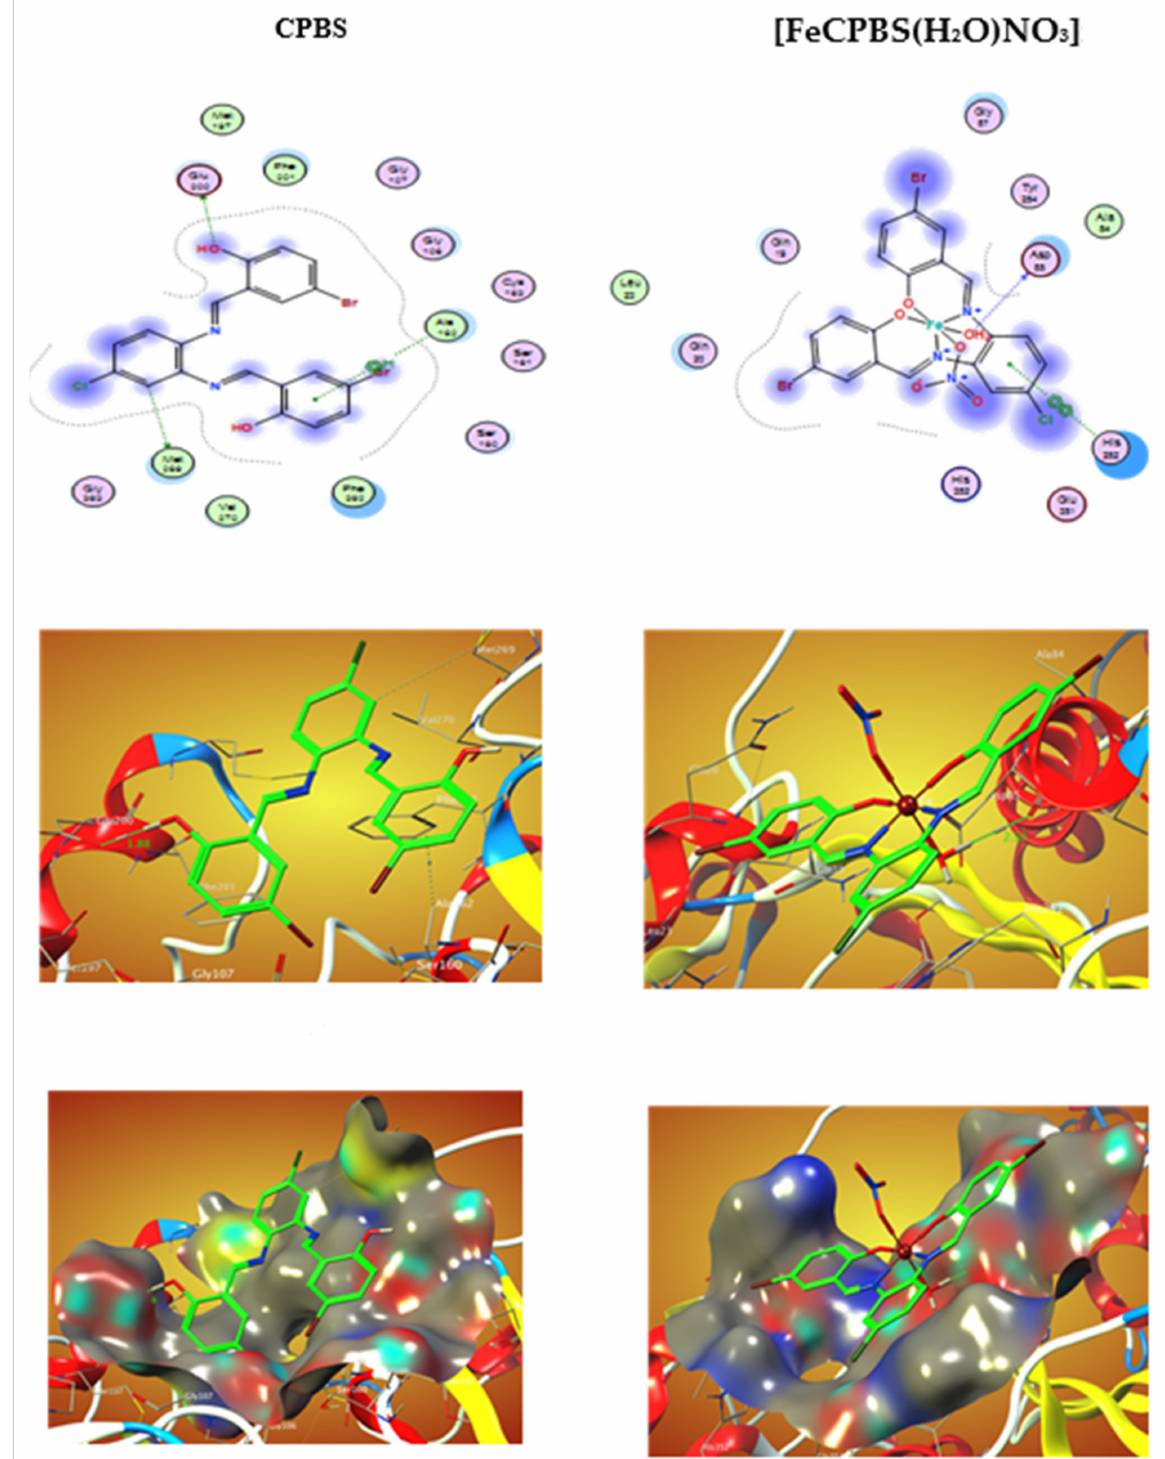
Figure 10. 2D and 3D plots of the interaction between CPBS and [FeCPBS(H 2 O)NO 3 ] with the active site of the Escherichia coli protein receptor (PDB ID: 1fj4). Dotted curves depict hydrophobic interactions with amino acid